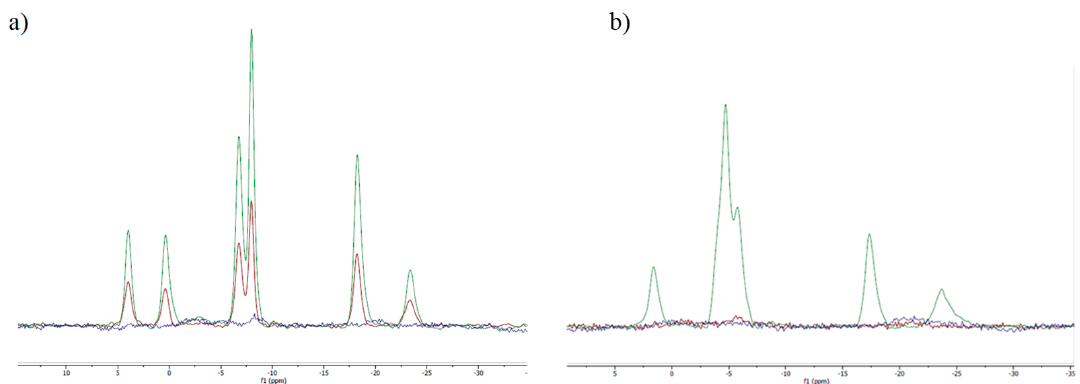
Figure 5. ( a ) 11 B{ 1 H}-NMR spectra of 2 mM of Na[ o- COSAN] in aqueous solution (green), in DMEM culture medium solution (red), in DMEM + 10% FBS solution (blue). ( b ) 11 B{ 1 H}-NMR spectra of 2 mM of Na[8,8 ′‐ I 2 ‐ o ‐ COSAN] in aqueous solution (green), in DMEM culture medium solution (red), in DMEM + 10% FBS solution (blue).